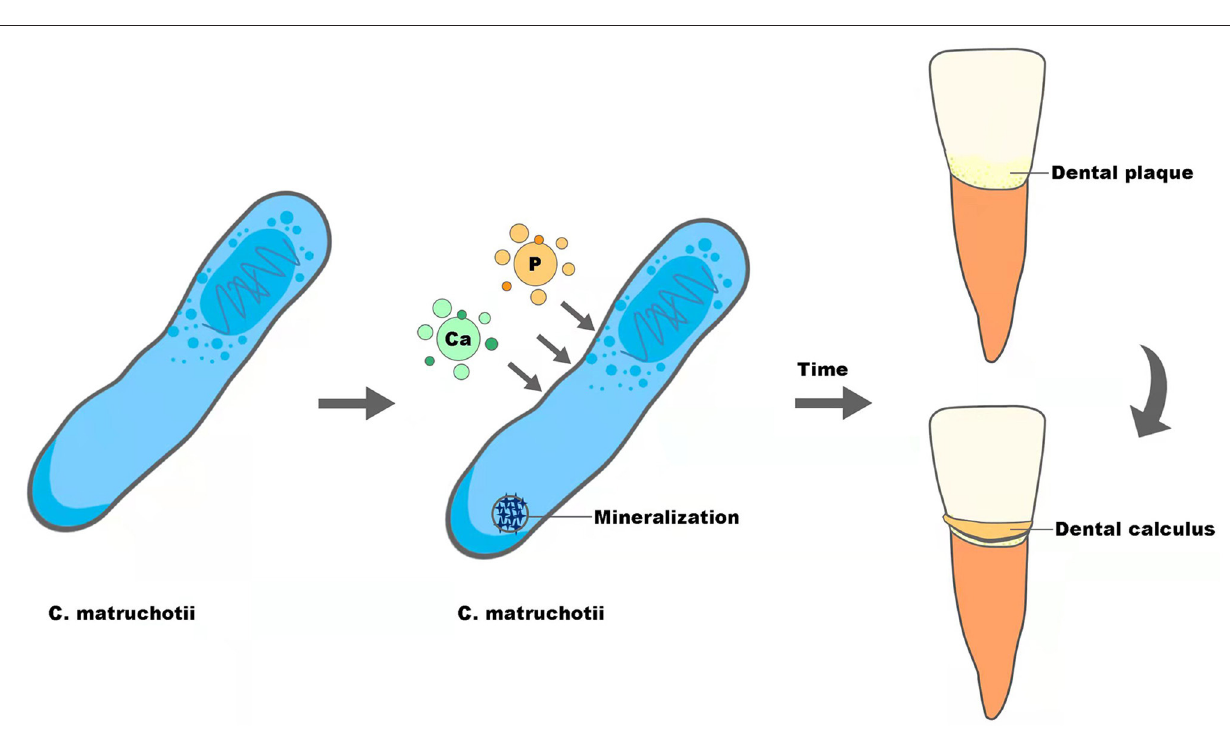
FIGURE 2 | The potential role of C. matruchotii in the formation of dental